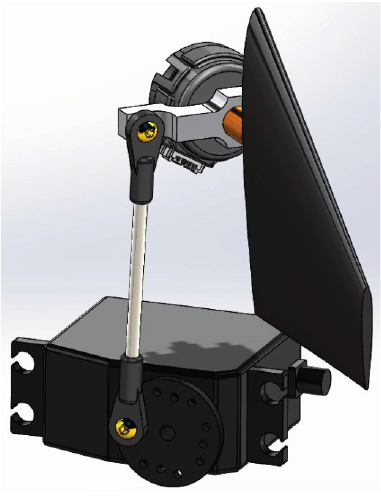
Figure 5. Close up of actuation mechanism for Smokey.